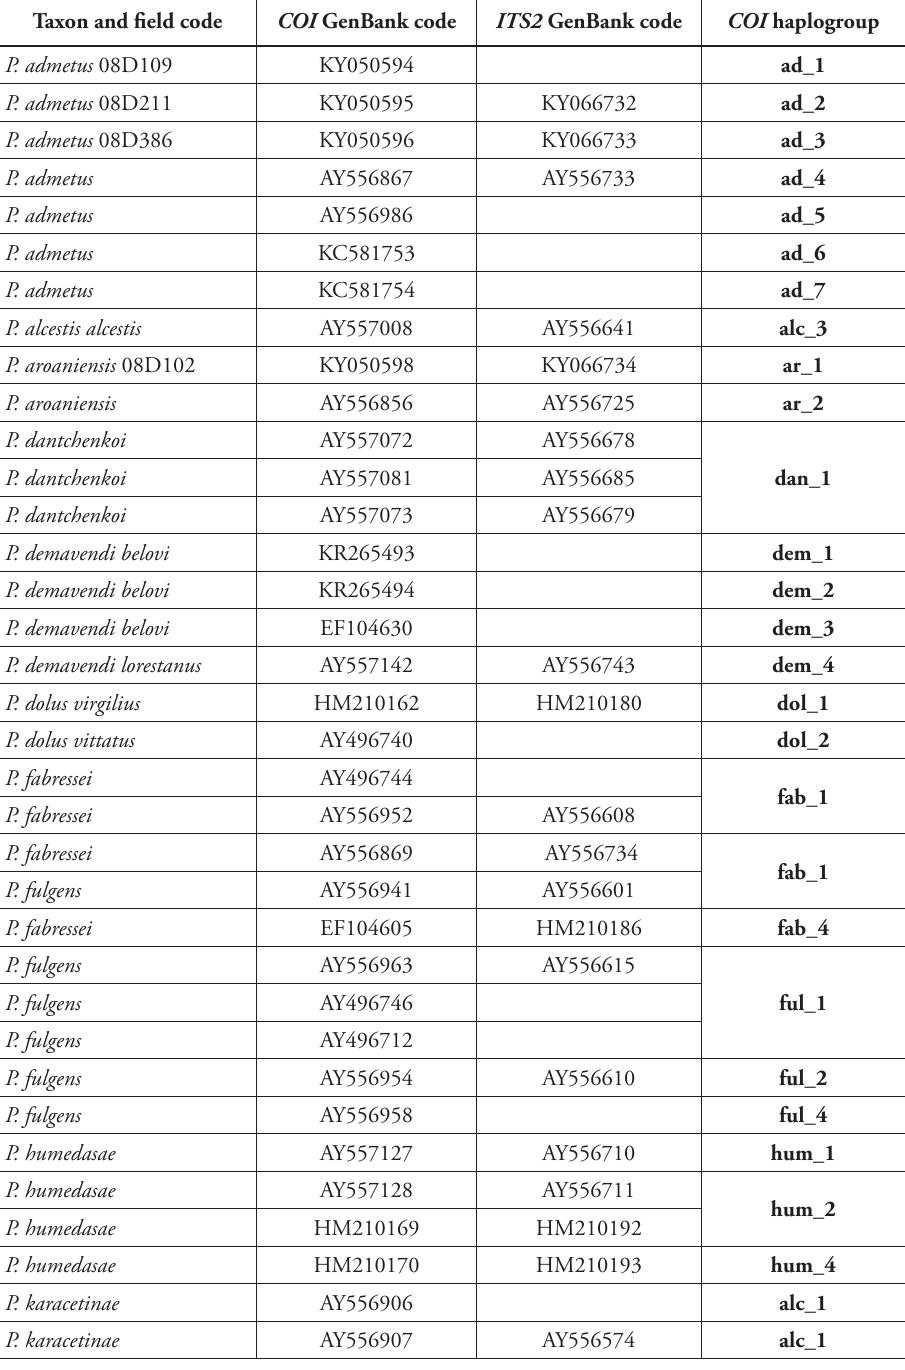
Table 2. List of samples and haplogroups used for the present study. Taxon and field